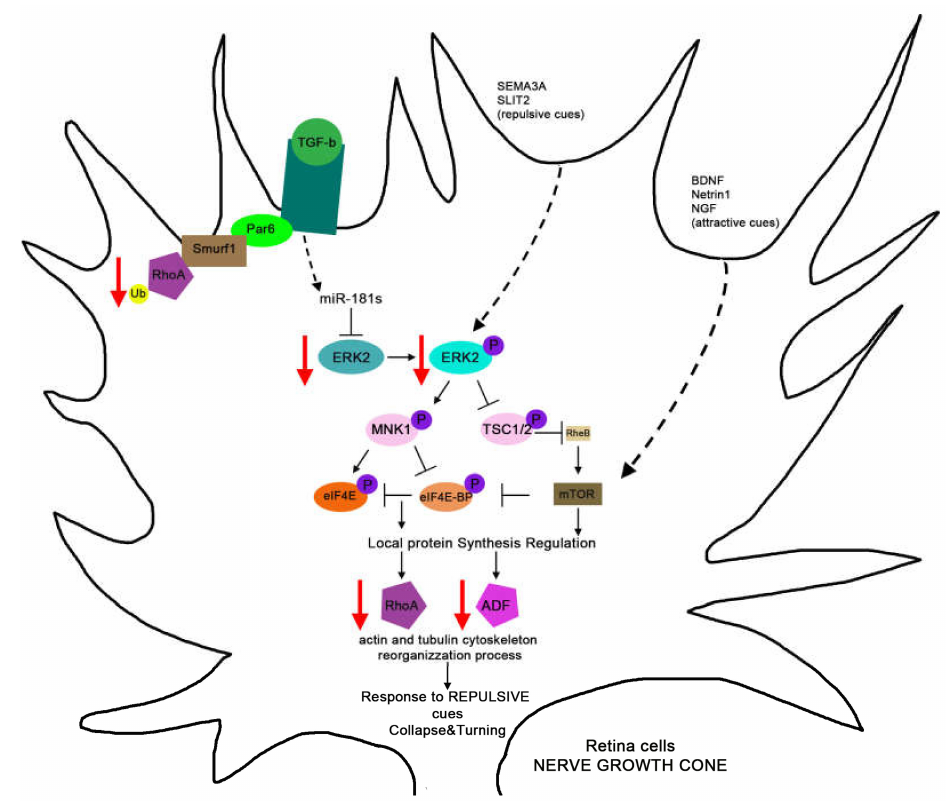
Figure 2. Model for the regulation and function of miR-181a / b in axon specification and growth processes. The TGF- β / MAPK signaling antagonism in the neuronal process formation is exerted via miR-181a / b. The TGF- β signaling regulates, on one hand, the RhoA degradation, and, on the other, the RhoA protein synthesis decrease via regulation of miR-181a / b levels. The miR-181a / b, by regulating the ERK2 levels, can modulate the MAPK signaling cascade and the protein synthesis of RhoA, allowing its physiological down-regulation, needed for neuron polarization and rapid elongation of the neurite. Then during axon elongation, the miR-181a / b e ff ect on ERK2 levels is needed in the modulation of MAPK signaling and Protein synthesis of RhoA and Cofilin (Actin Depolymerization Factor), responsible for cytoskeletal modification involved in axon growth cone collapse and